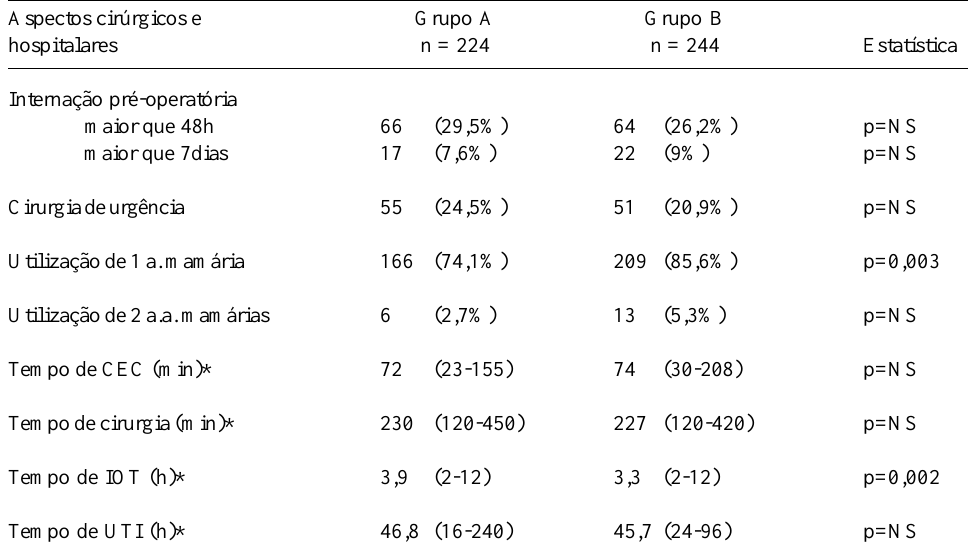
Tabela 2. Aspectos cirúrgicos e hospitalares em cada